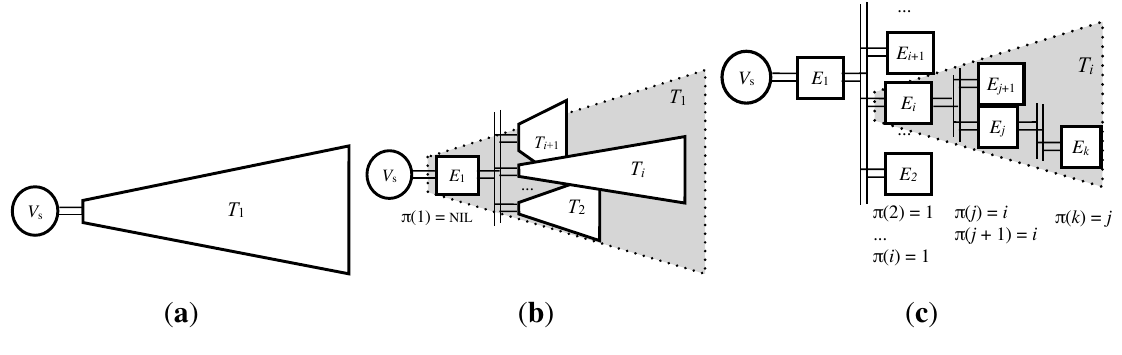
Figure 4. Notation for the trees: ( a ) T ( c ) generalization of tree